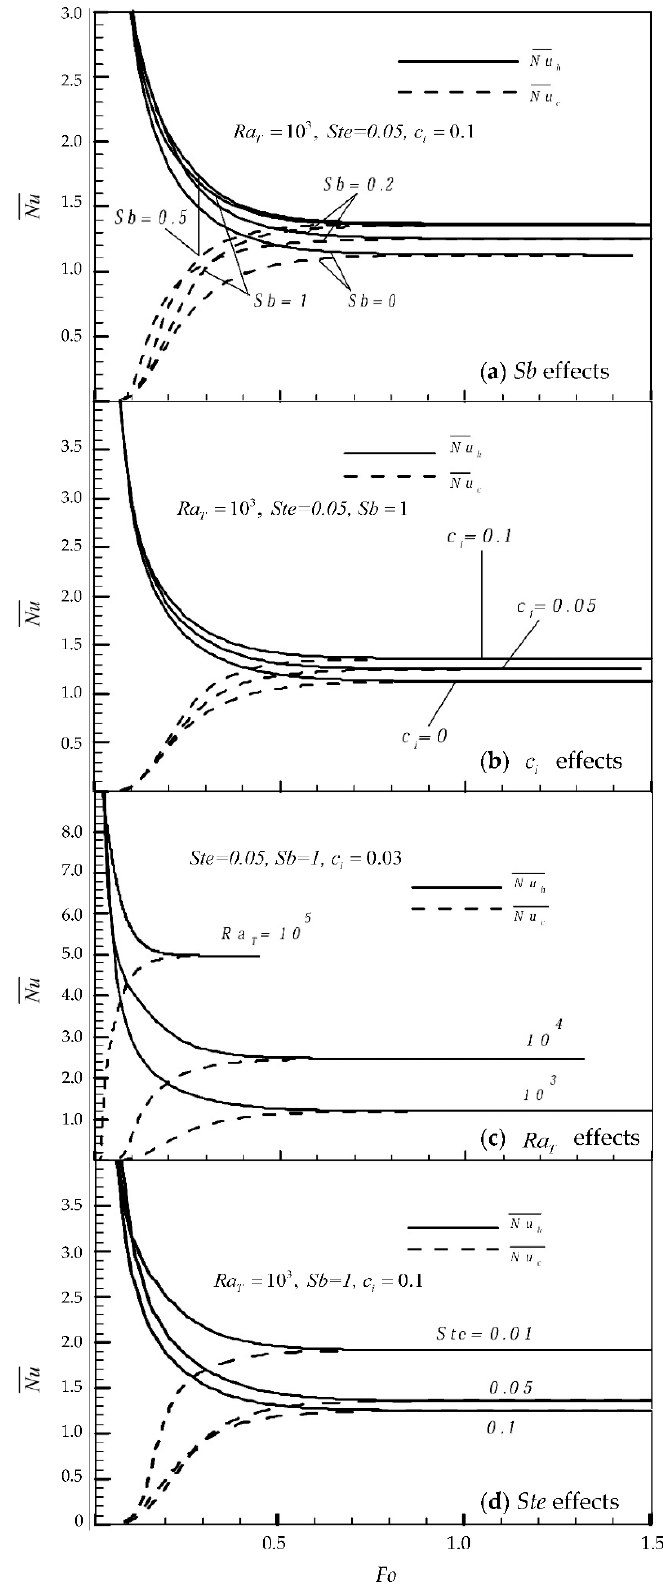
Figure 5. Transient development of the average Nusselt numbers of the hot and cold walls.